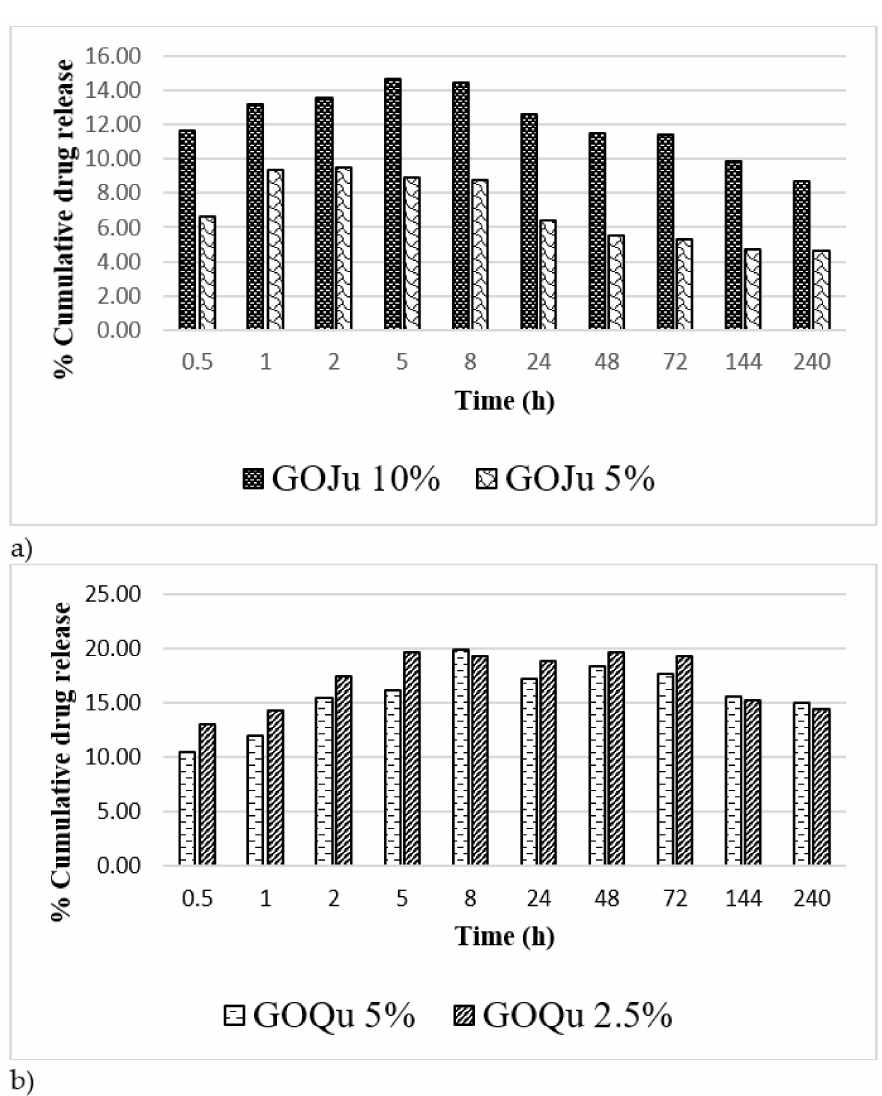
Figure 7. The release profile for ( a ) GOJu 10% ( w / v ) and GOJu 5% ( w / v ), and ( b ) GOQu 5% ( w / v ) and GOQu 2.5% ( w / v